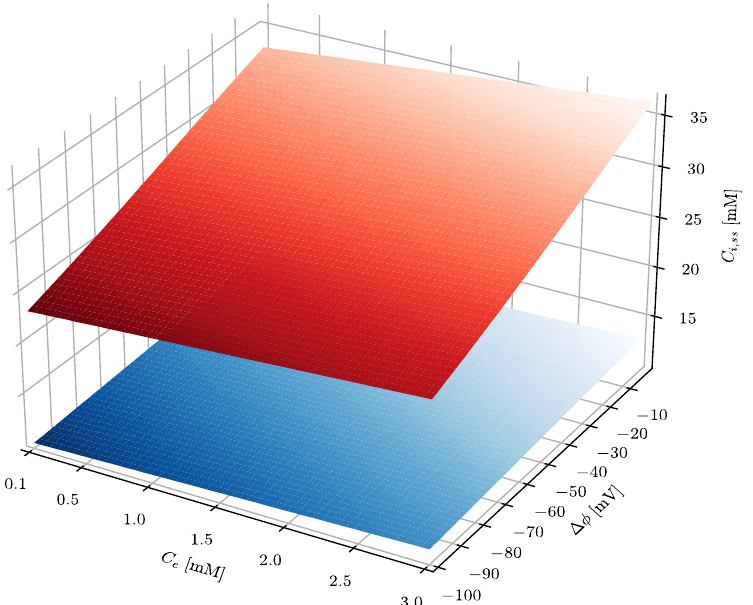
Figure 2. The effect of the plasma membrane electrical potential difference and ascorbate concentra- tion in serum on the steady-state ascorbate concentration inside a cell. The serum pH e equals 7.4, whereas intracellular pH i equals 7.5 and 7 for cancer and healthy cells, respectively. The blue and red surfaces show the intracellular steady-state level of ascorbate in healthy and cancer cells,